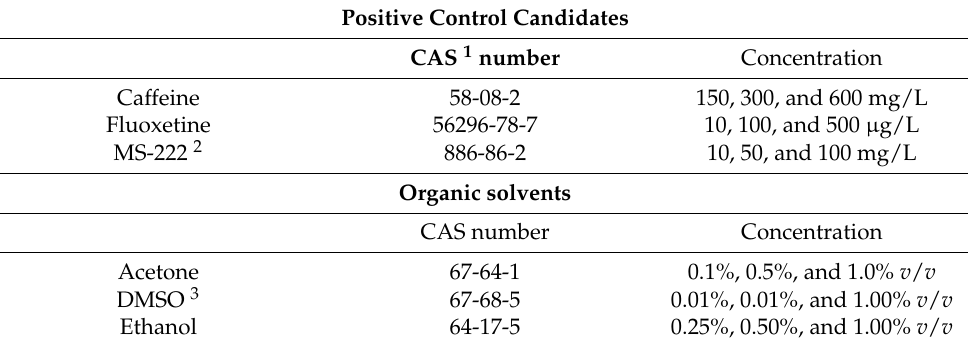
Table 1. Concentration ranges of substances tested in the tail coiling